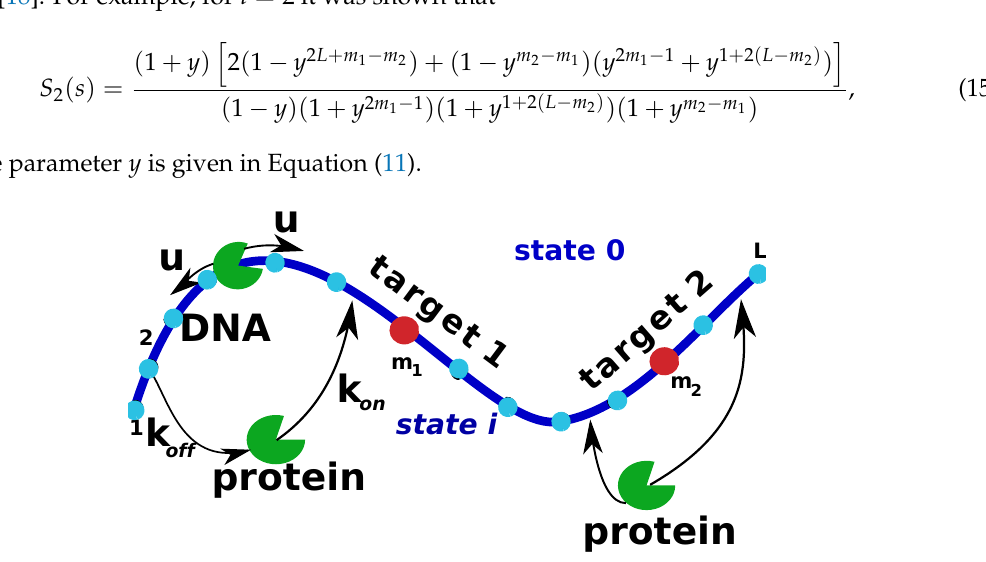
Figure 3. A schematic view of the discrete-state stochastic model of the protein search with multiple specific sites. Targets are located at the sites m 1 and m 2